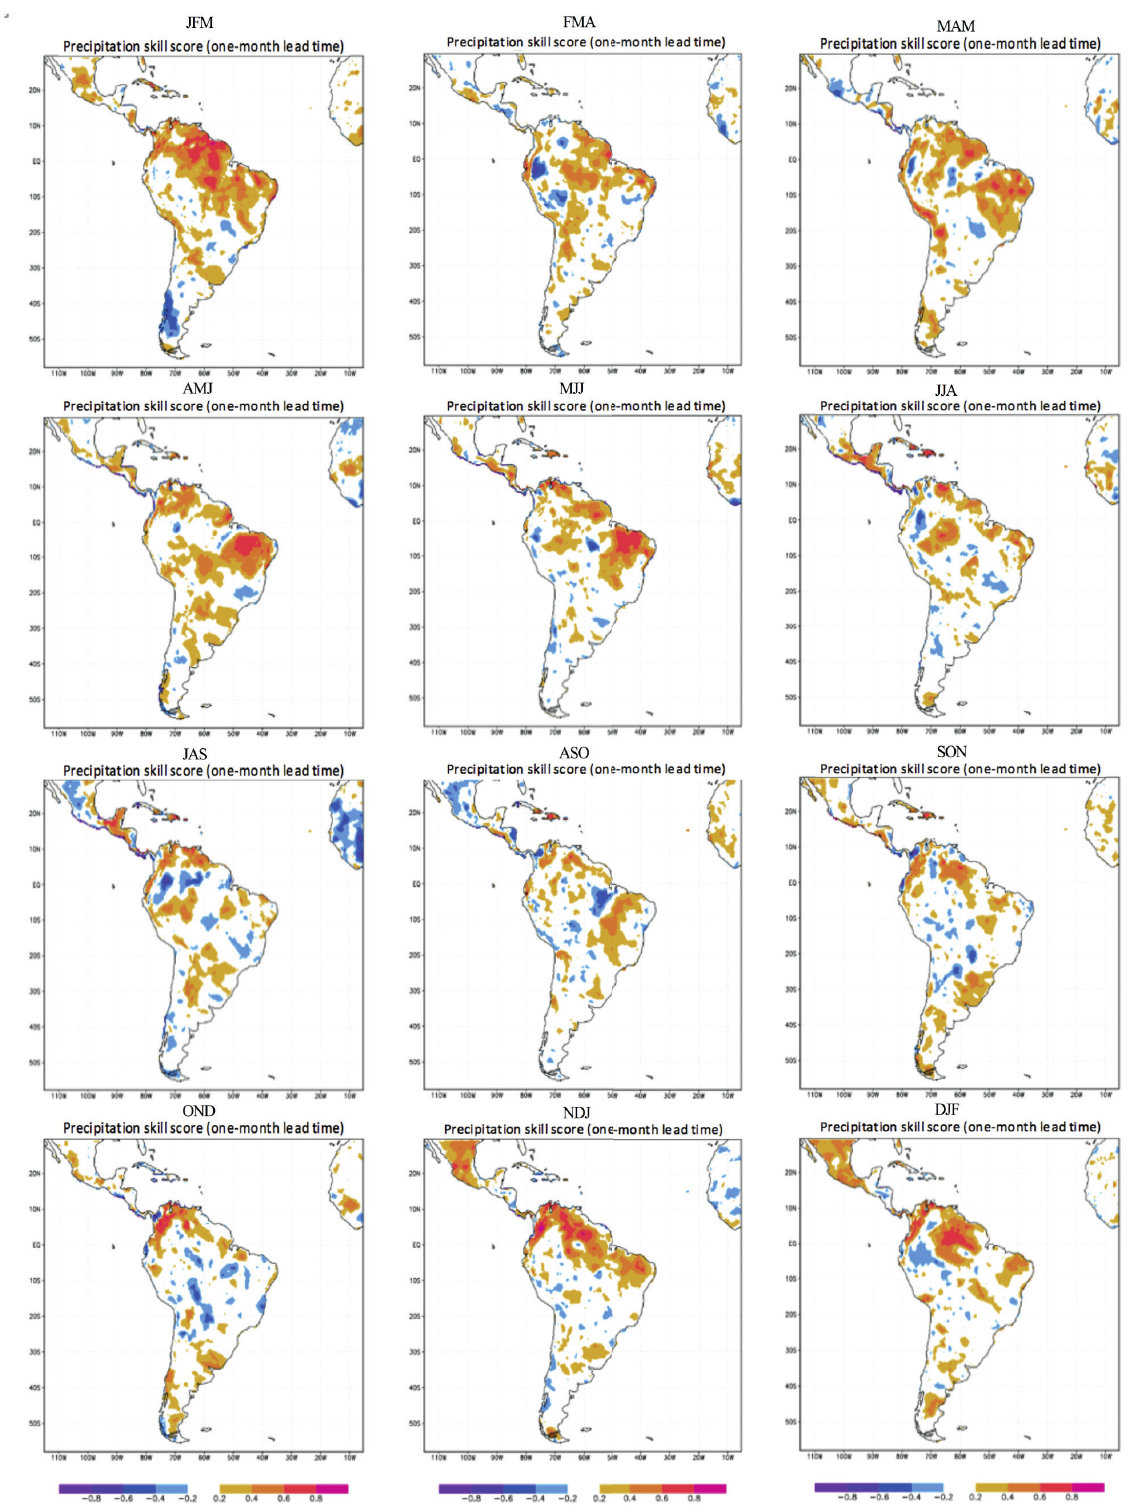
Figure 8. Precipitation skill scores for the Eta model with one-month lead-time forecasts for the seasons: JFM, FMA, MAM, AMJ, MJJ, JJA, JAS, ASO, SON, OND, NDJ, and